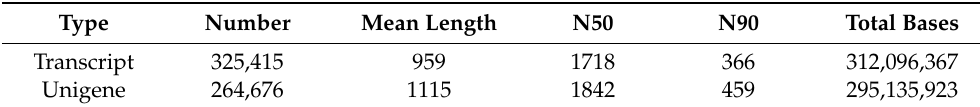
Table 2. Statistics of splicing results of Korean pine